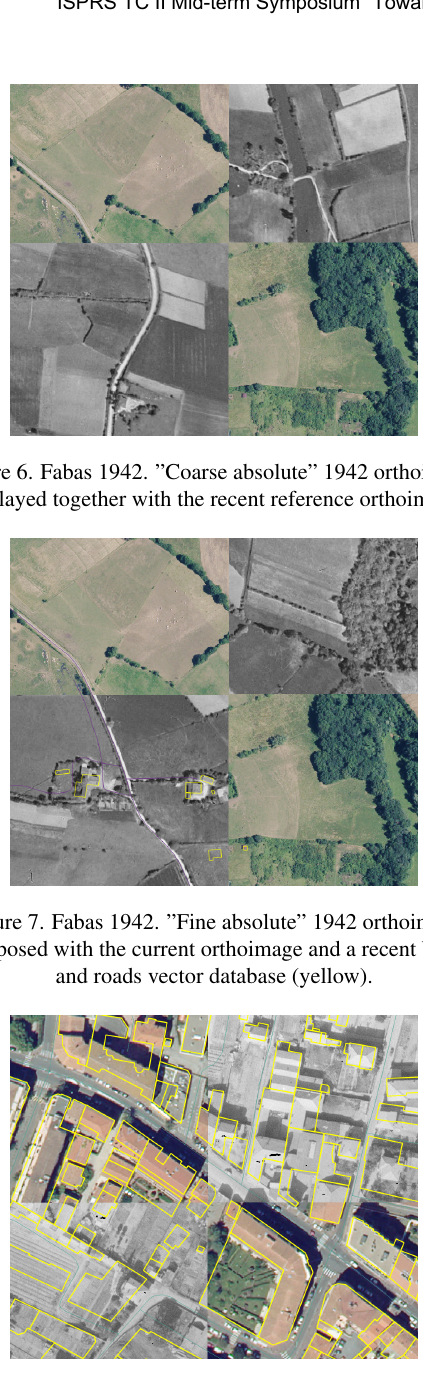
Figure 8. Frejus 1954. ”Fine absolute” 1954 orthoimage superimposed with the current orthoimage and a recent buildings and roads vector database (yellow).